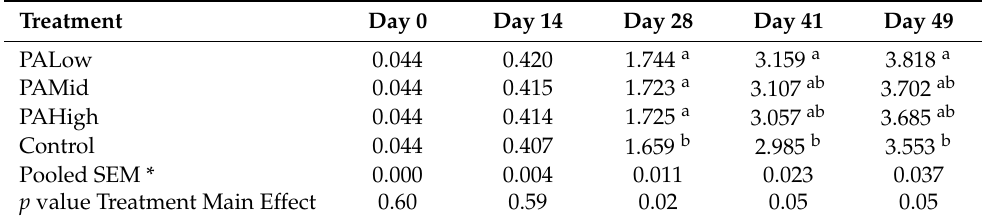
Table 6. Average live bird weights (kg) during growout in Experiment